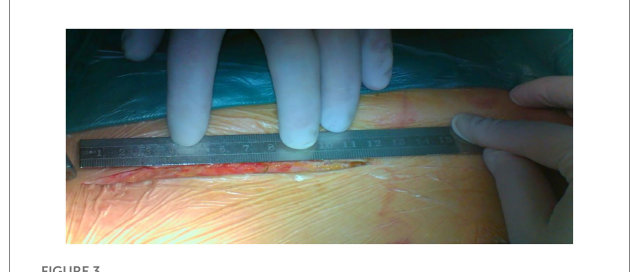
FIGURE 3 The length of the incision in partial upper sternotomy.